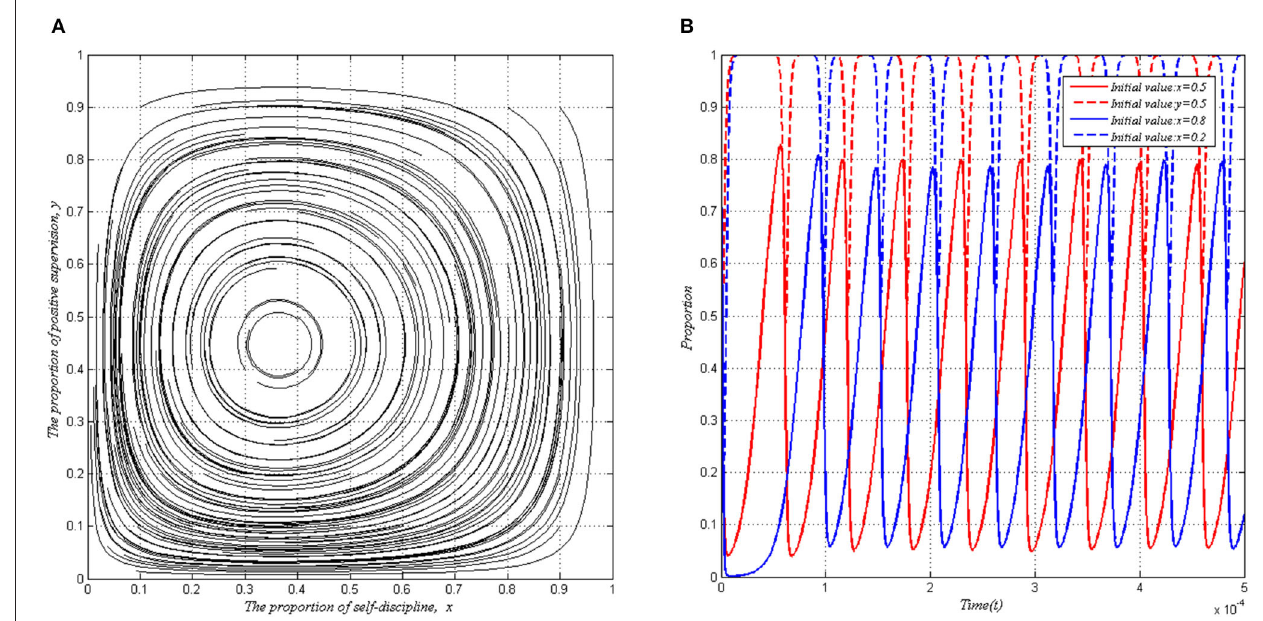
FIGURE 3 | Evolutionary stability of system I when P > max ( I , C